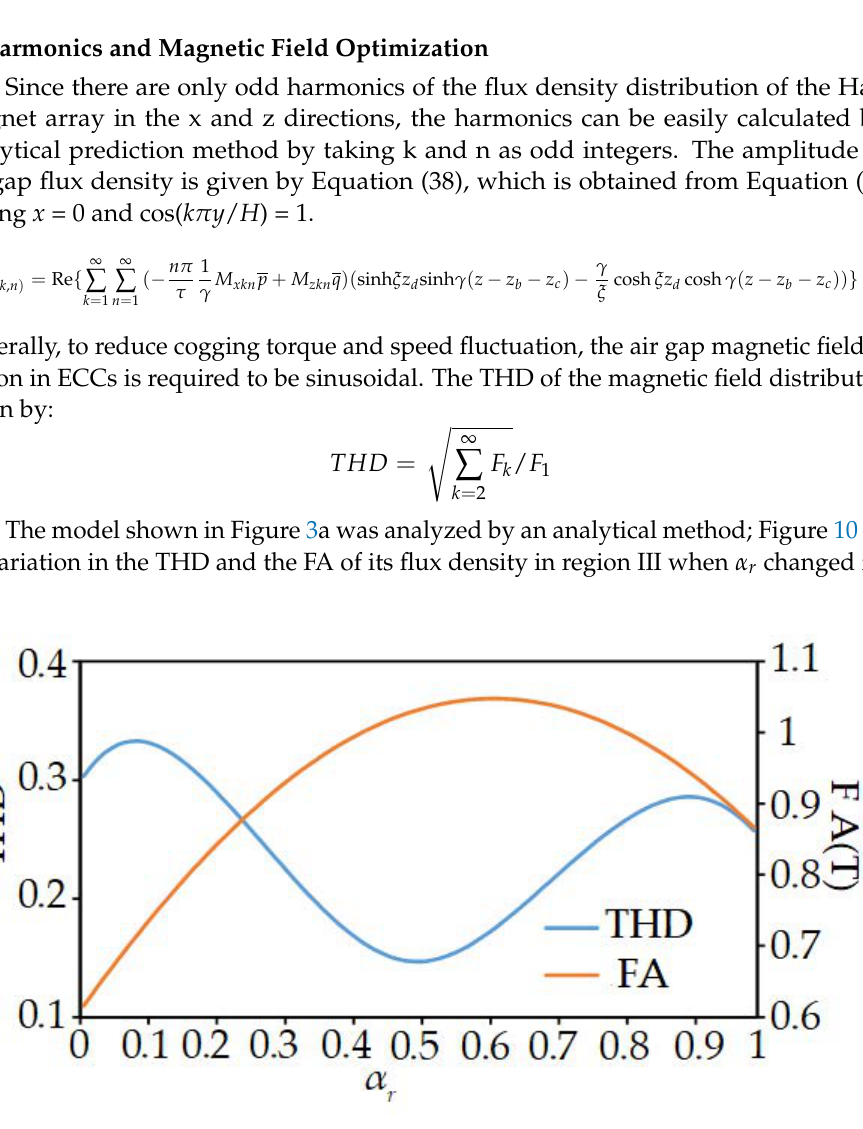
Figure 10. Predicted variation of THD and FA of two-segment Halbach magnet array. α r represents the x-direction length ratio of the z-direction magnetized PM to τ